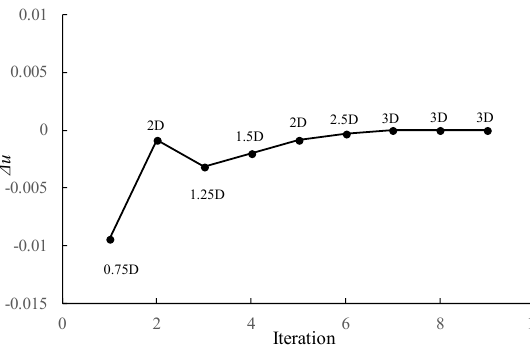
Figure 10. Results from the iterative wake length procedure of the train. Table 1. Comparison of peak values and base pressure for trains with different panel numbers. 100 Panels 200 Panels 300 Panels Position C p Position C p C